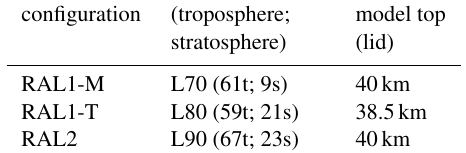
Table 1. Vertical level sets used in RAL1 and RAL2.